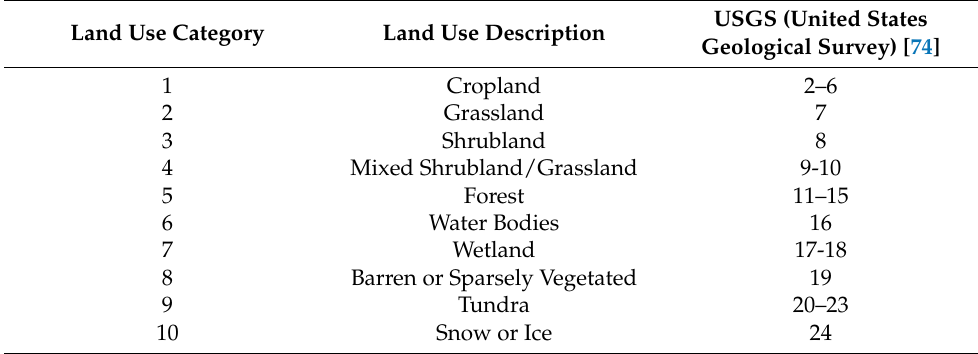
Table 2. Reclassified 10-category land-use categories. Land Use Category Land Use